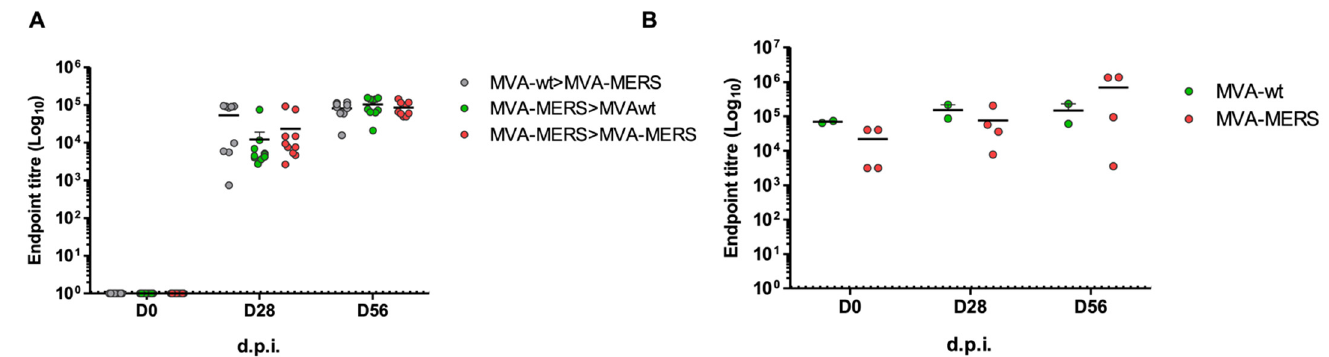
Figure 4. Antibody specific to MVA in immunised mice and camels. Serum samples collected from immunised mice ( A ) and camels ( B ), as explained in Figures 2 and 3, were tested in a whole-virus in-house ELISA for anti-MVA antibodies, reported as Log10 endpoint titres. Mean values are shown as lines.